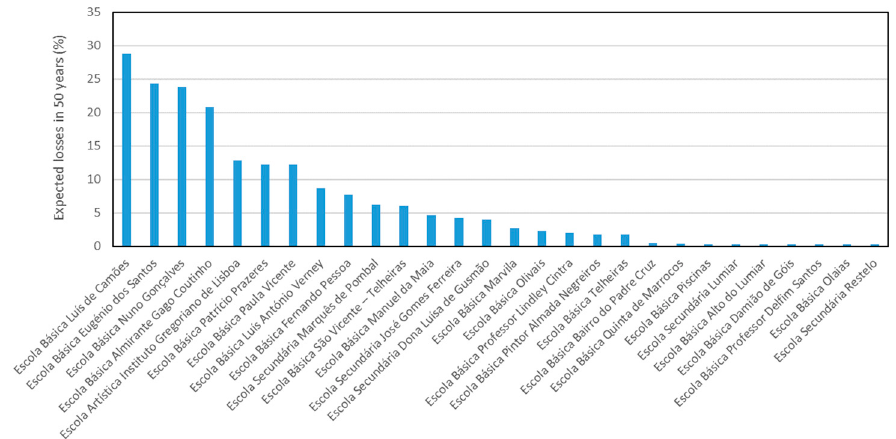
Figure 12. School ranking according to expected losses over 50 years (as a percentage of school ar-